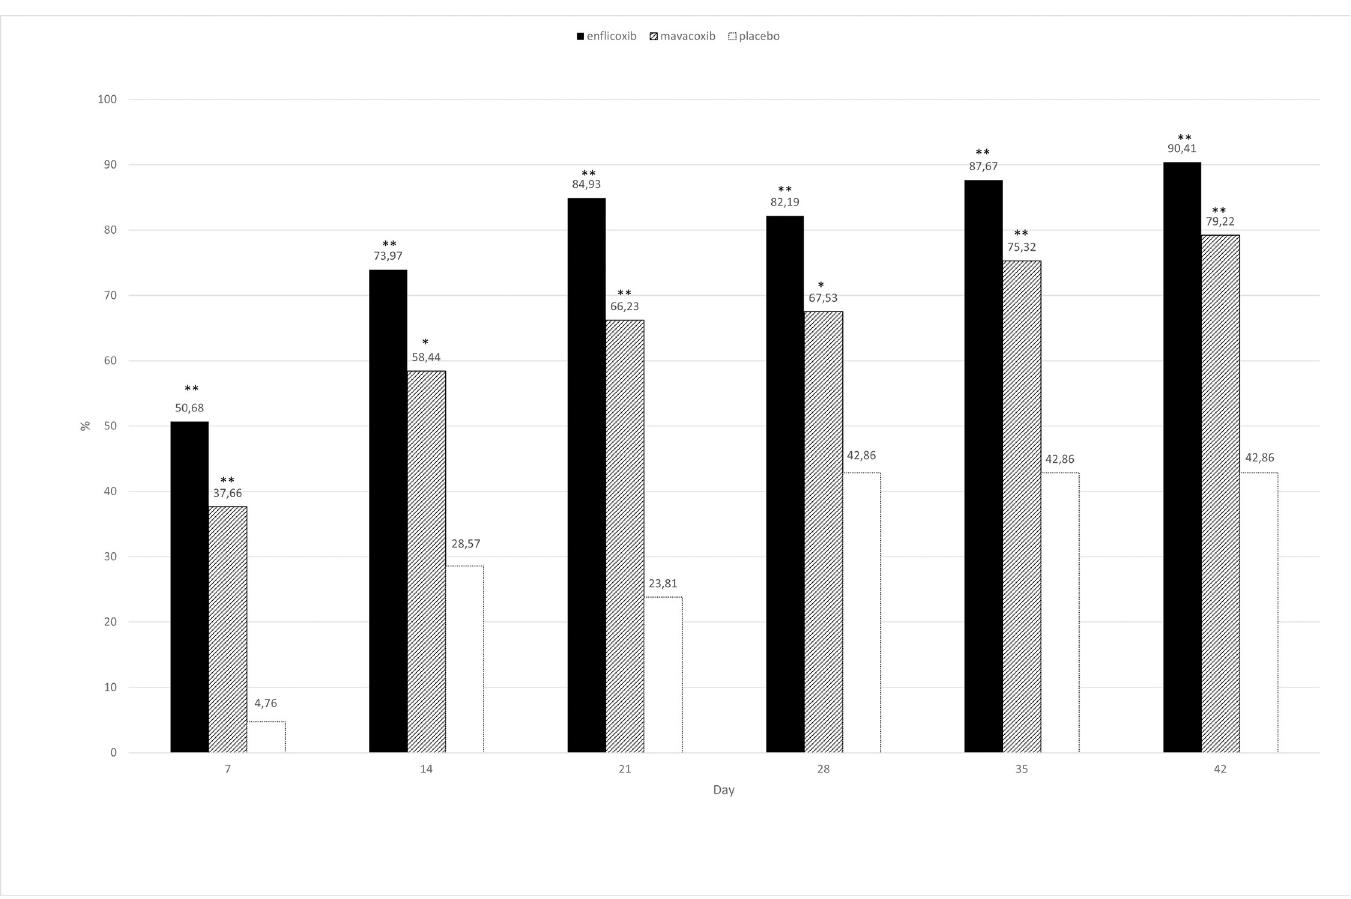
Fig 5. Percentage of CBPI responders (reduction in PSS � 1 and PIS � 2) in each treatment group and time point during the study. Asterisks indicate superiority vs placebo ( � p < 0.05 �� p < 0.01).